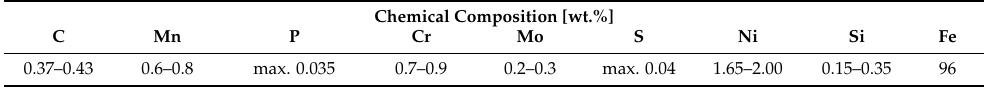
Table 1. The chemical composition of the steel AMS6415 according to material list [34,35].